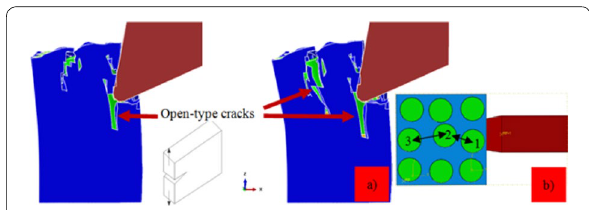
Figure 13 Open-type cracks in cyanate ester